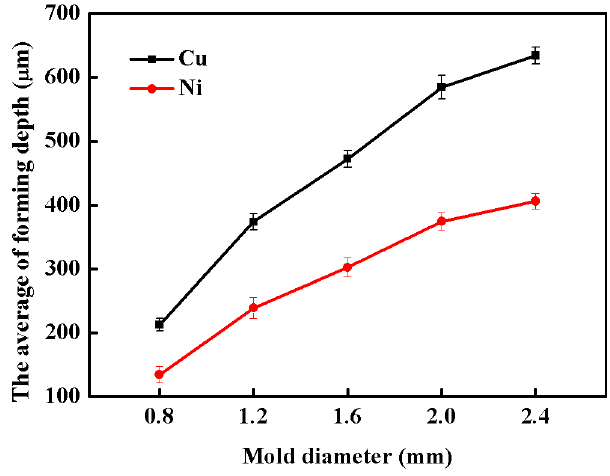
Figure 5. The forming depth of formed components of monolithic Cu and monolithic Ni.